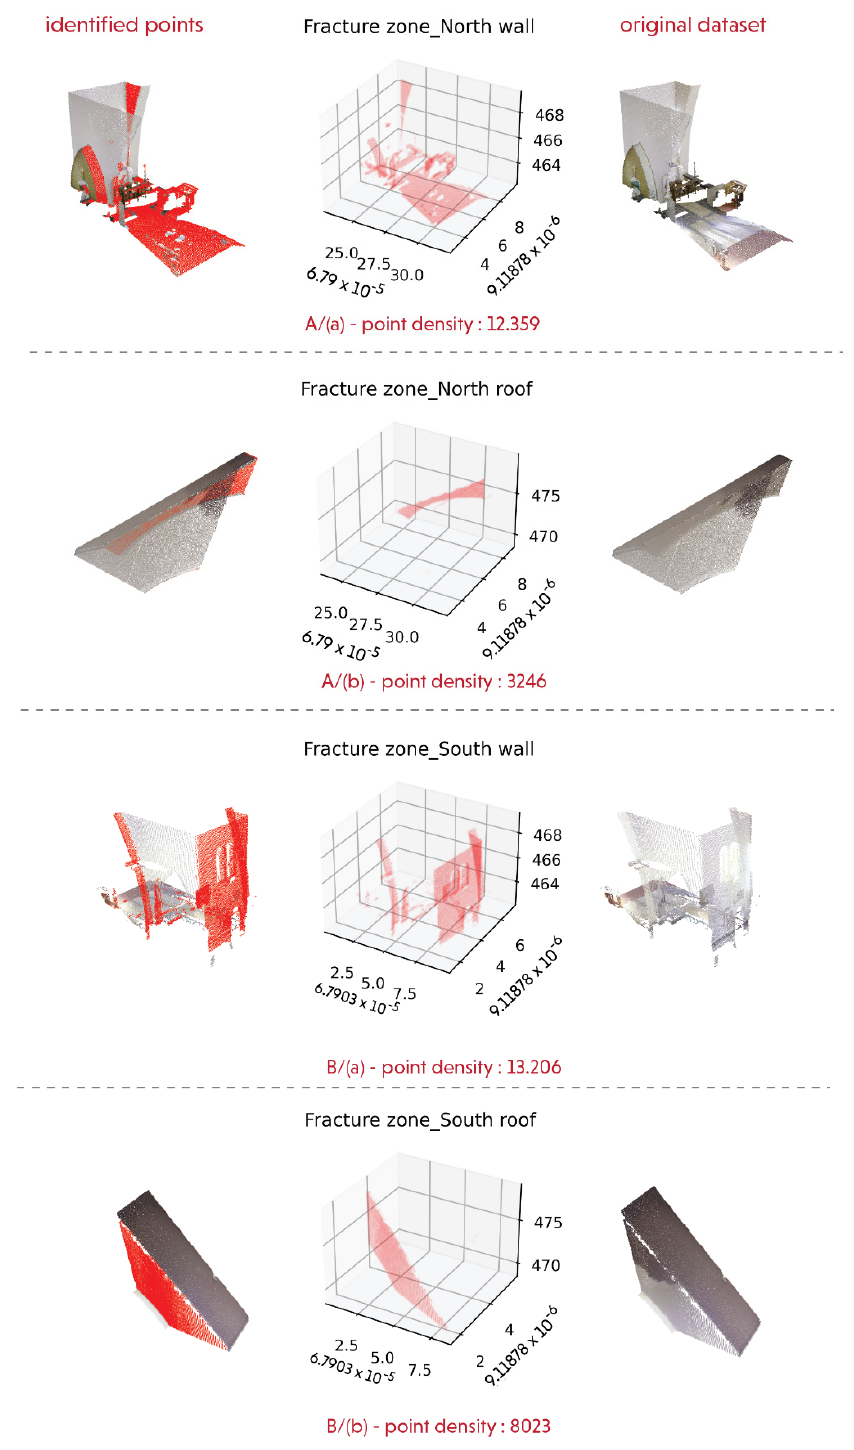
Figure 5. Fracture plane points based on segmented datasets: A /( a ) Fracture zone–North wall; A /( b ) Fracture zone–North roof; B /( a ) Fracture zone–South wall; B /( b ) Fracture zone–South roof